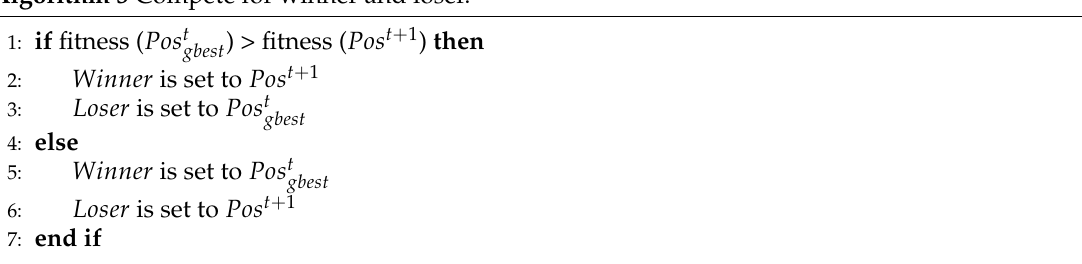
Algorithm 3 Compete for winner and loser.